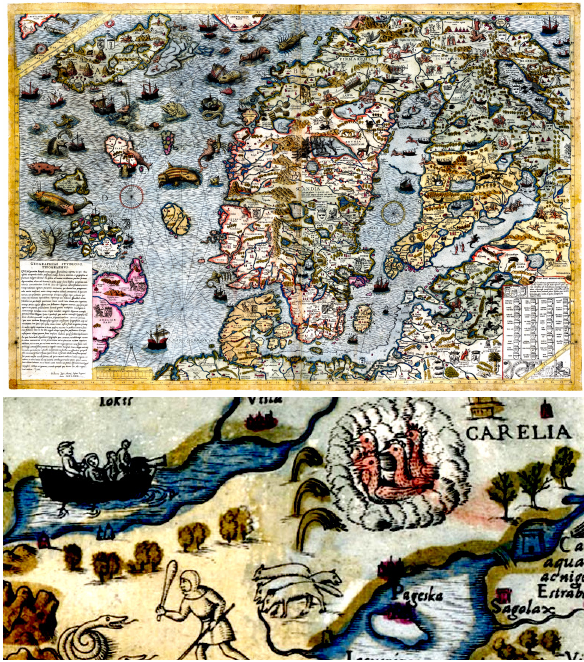
Figure 11: Olaus Magnus, 1572, Carta